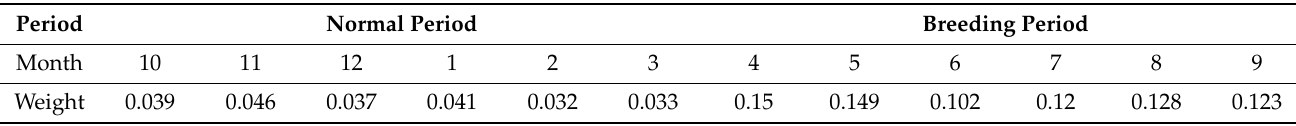
Table 7. Indicator weights in different